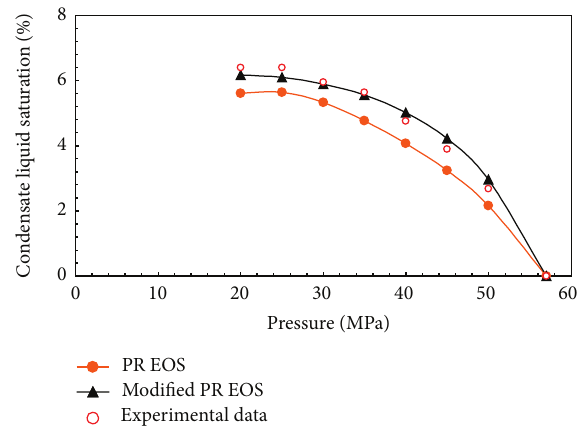
Figure 4: The contrast curve about the calculated retrograde condensate oil saturation in the equilibrium pressure drop by the modified PR EOS and PR EOS, the measured retrograde condensate oil saturation in the equilibrium pressure drop constant volume depletion